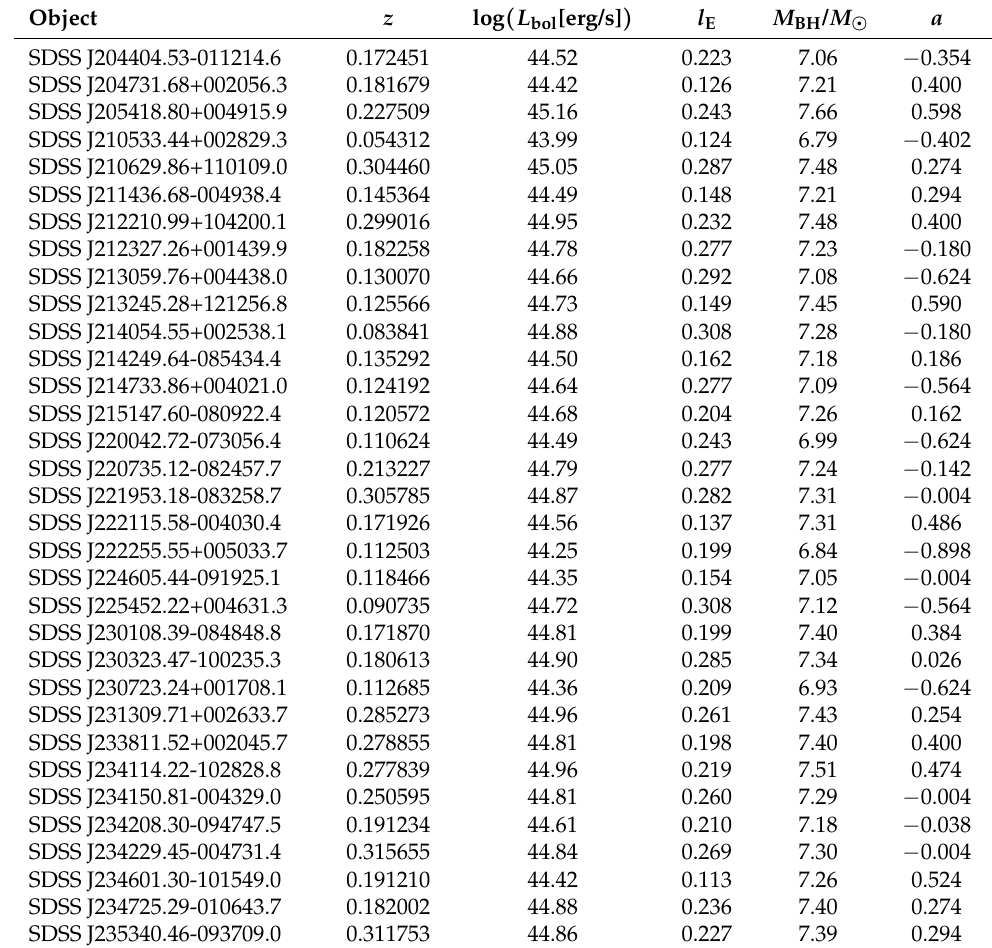
Table A8. All objects with their estimated spin values. Part 8 of